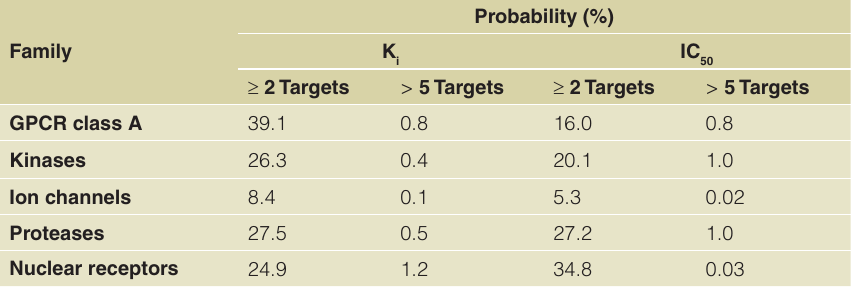
Table 4. Probability of promiscuity for compounds active against prominent target